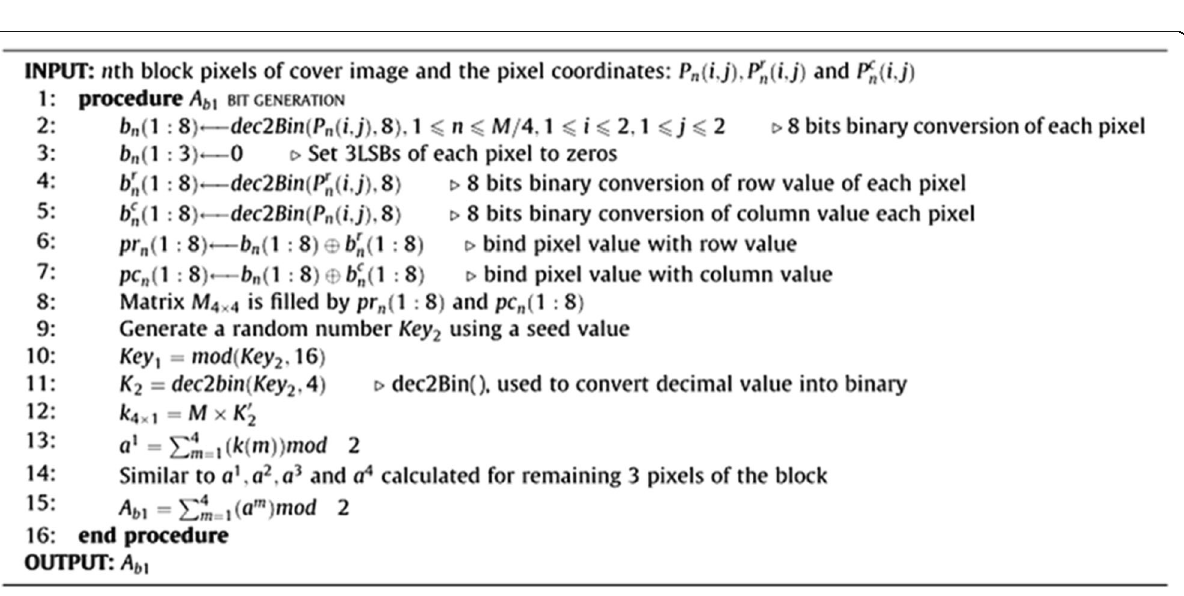
Fig. 6 First authentication bit generation of Singh ’ s scheme